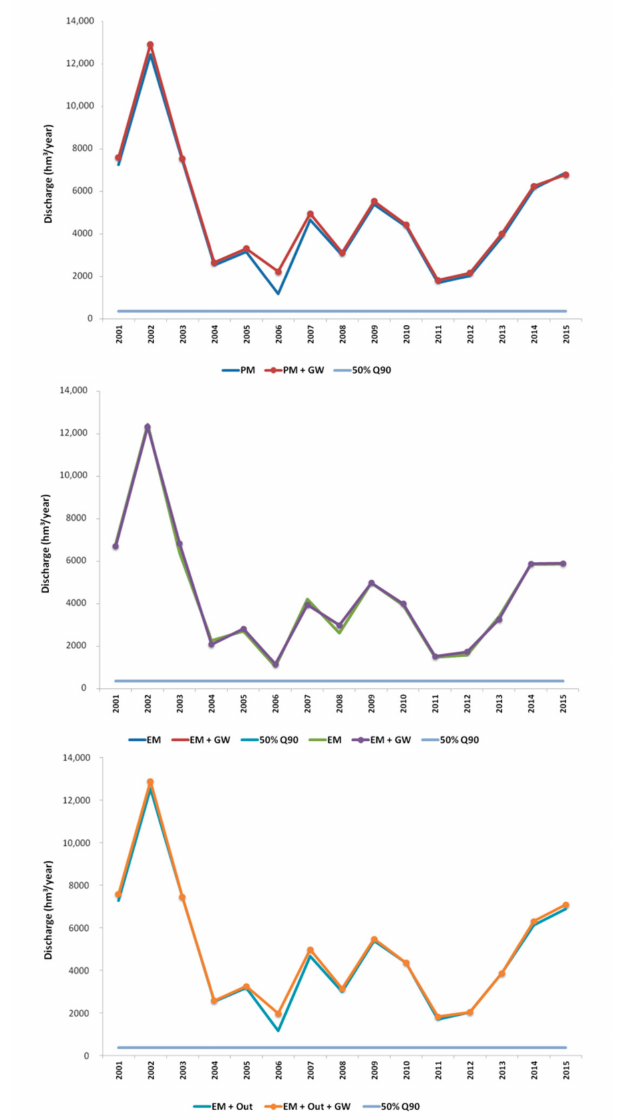
Figure 10. Comparison between the outflows on all simulated scenarios with the limited outflow (50% of the